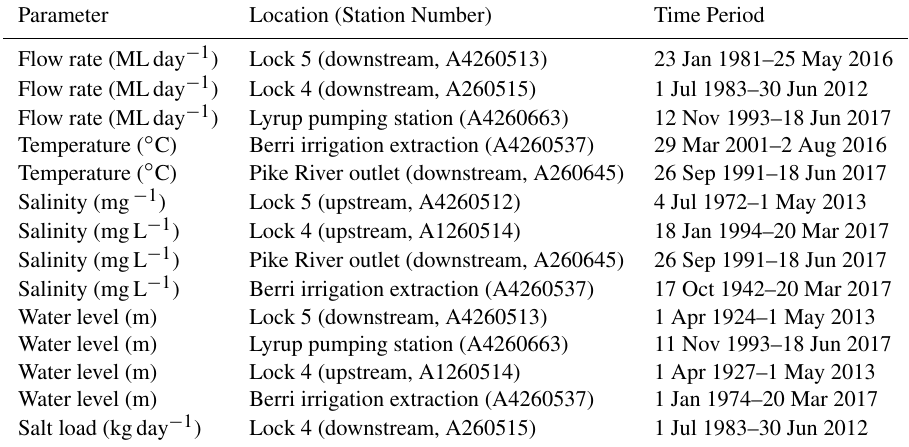
Table 1. Details of available model data. All data are recorded at a daily resolution and have been sourced from DEW (Department of Environment, Water and Natural